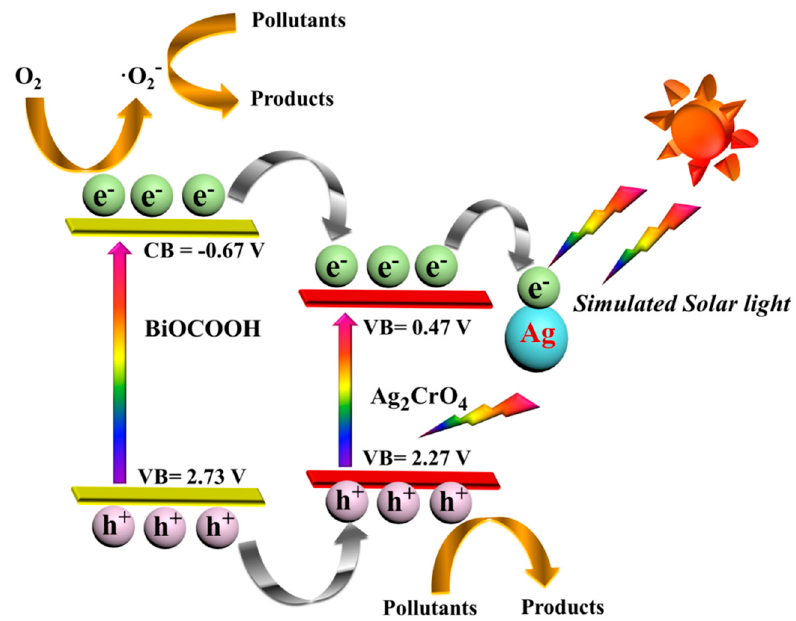
Figure 11. The proposed photocatalysis mechanism of Ag / Ag 2 CrO 4 / BiOCOOH under simulated solar light.